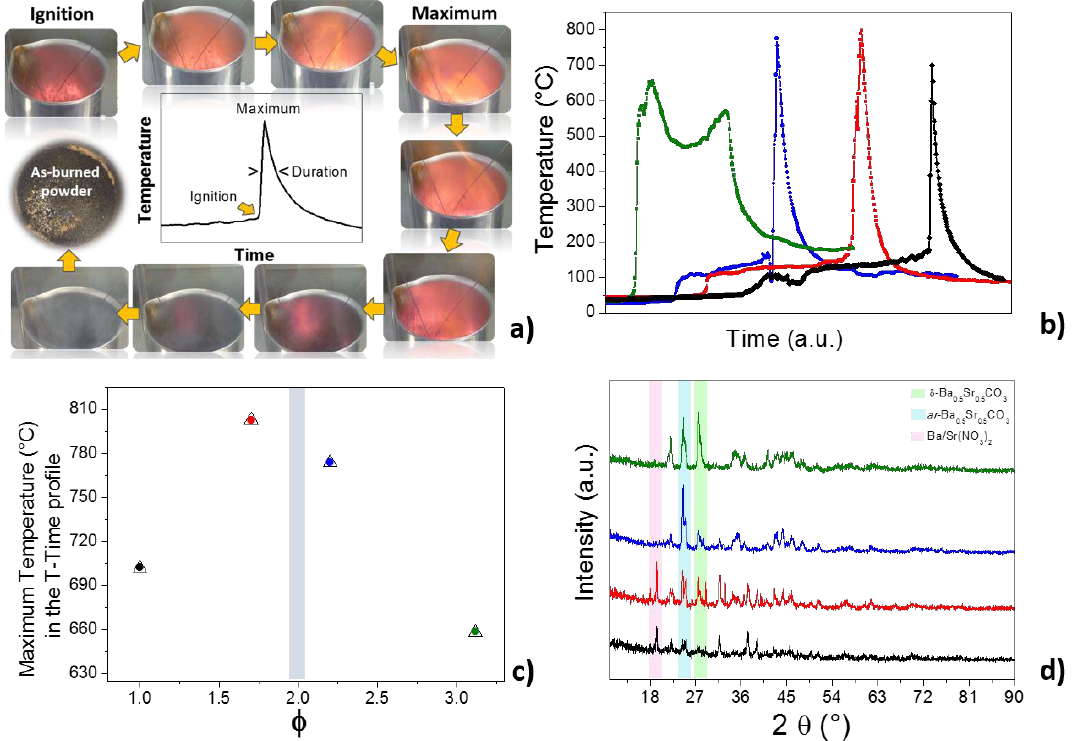
Figure 1. ( a ) Sequential pictures of a typical combustion process of a BSCF prepared by SCS from a sucrose–PEG 20,000 mixture leading toward the as-burned powder, showing the three most meaningful features of a temperature / time profile; ( b ) comparison between temperature / time profiles registered for BSCF10 (black), BSCF17 (red), BSCF22 (blue) and BSCF31 (green); ( c ) volcano-type trend of the maximum temperature in the temperature / time profiles as a function of Φ ; ( d ) XRD patterns of as-burned BSCF10 (black), BSCF17 (red), BSCF22 (blue) and BSCF31 (green). Colored rectangles evidence the main peak of the three Ba / Sr-containing intermediate phases.